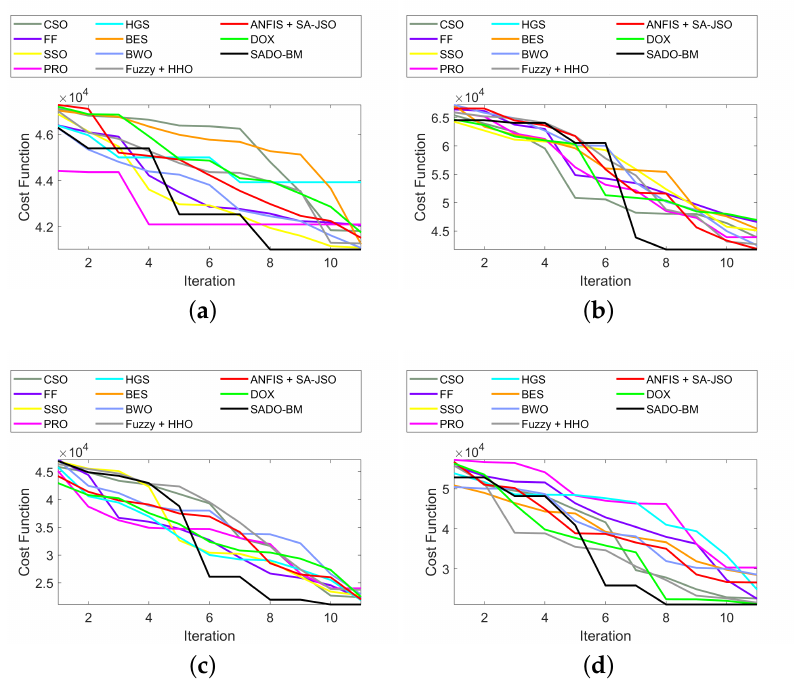
Figure 3. Convergence of SADO-BM over other models for node counts ( a ) 100, ( b ) 250 ( c ) 750, and ( d )